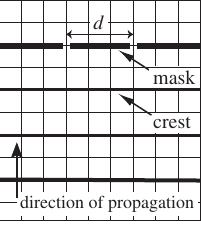
FIG. 3. To-scale diagram shown to students on the slit separation task.